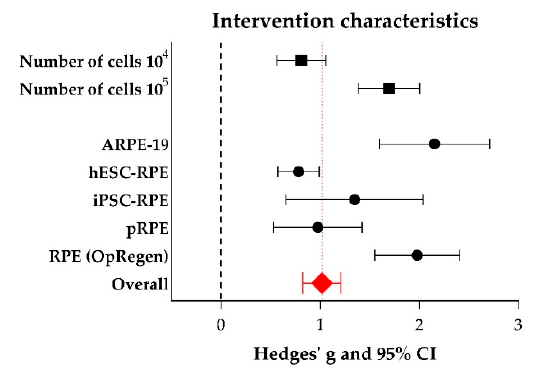
Figure 10. The effect of the number of transplanted cells and the origin of the cells on the outcome of vision-based behavioral assays. For every subgroup, Hedges’ g (a measure for effect size using smaller sample sizes, black solid squares) and its 95% confidence interval (CI) are graphically shown. The left side of the dashed black line (Hedges’ g = 0) favors the control group (untreated or sham-operated) and the right side favors the experimental group (RPE transplantation). Overall, RPE transplantation increased vision-based behavior (Hedges’ g 1.018 (0.826–1.209), red diamond). Significant better results were obtained when 10 5 cells were transplanted when compared to 10 4 cells (adjusted p -value 0.000036). The origin of the RPE cells which are transplanted matters as well, with ARPE-19 cells and OpRegen ® RPE being the best options.